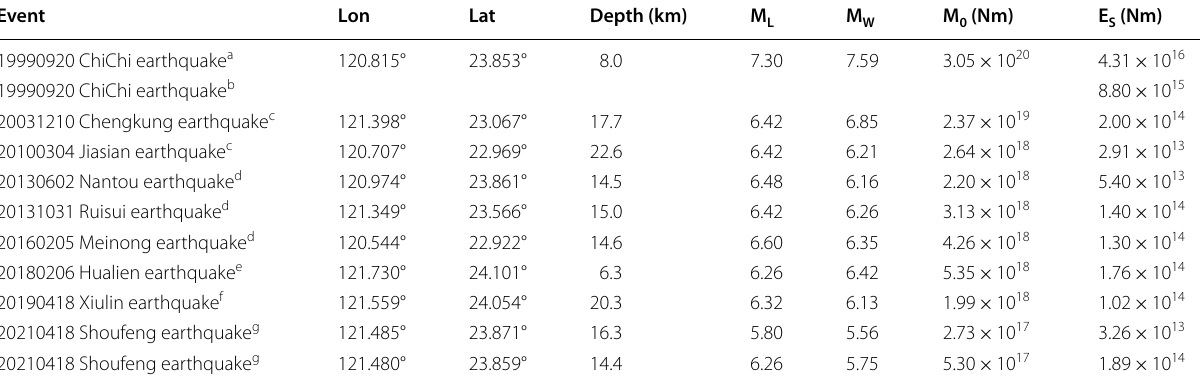
Locations and M L are from the CWB; M 0 and M W are from the USGS other than the 20210418 events a